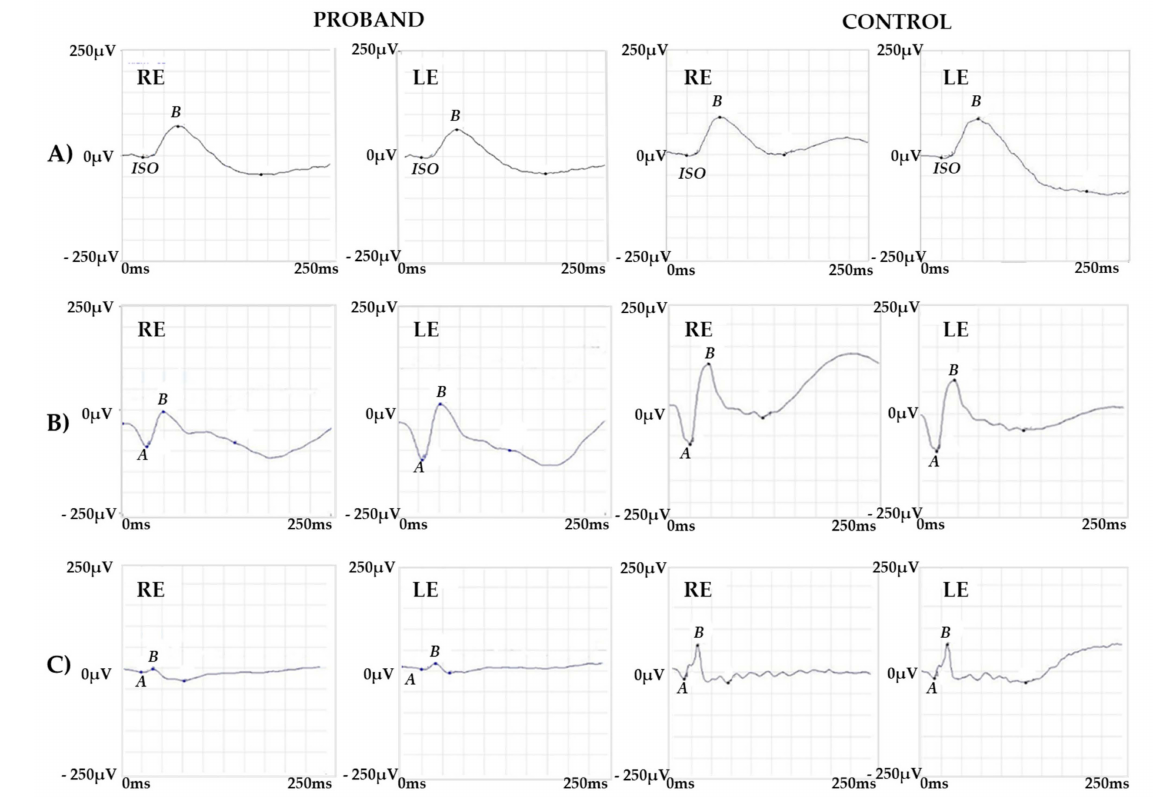
Figure 2. ERG Responses. ERG recordings showing ( A ) a normal amplitude response for the scotopic stimulus, ( B ) a slightly reduced response for the combined stimulus and ( C ) a severely reduced response for the photopic stimulus. Representative examples of ERG responses from a normal subject are shown for comparison. Legend: RE, right eye; LE, left eye; ISO, isoelectric line; A, a-wave; B, b-wave.